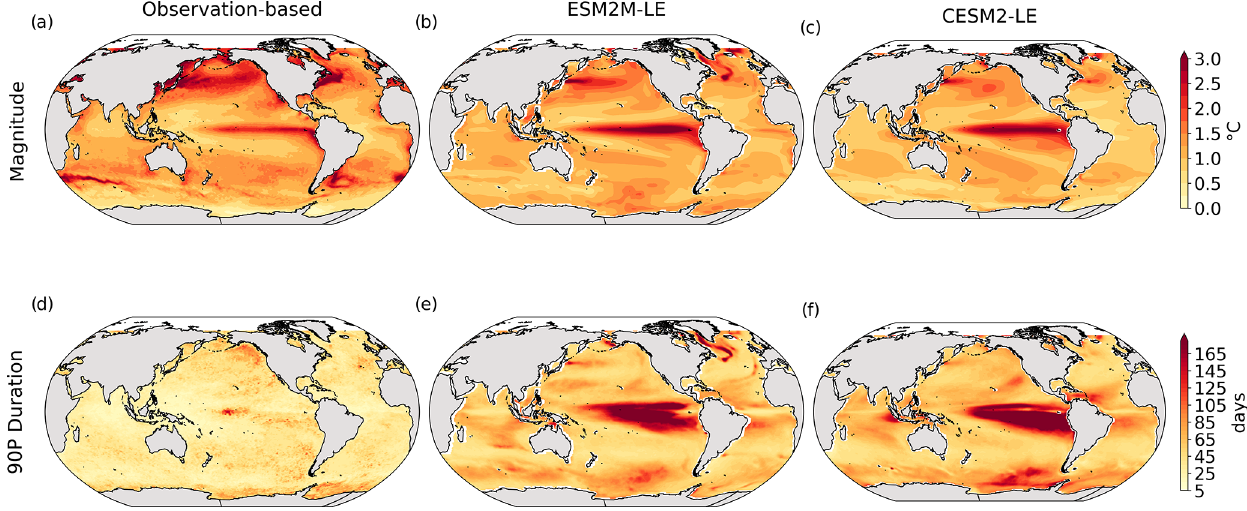
Figure B2. Simulated mean magnitude and duration of MHWs over 1998–2018. Mean SST anomaly relative to the seasonal cycle ( ◦ C) during MHWs in (a) the observation-based estimate, (b) ESM2M-LE, and (c) CESM2-LE. Simulated 90th percentile of the MHW durations (days) in (d) the observation-based estimate, (e) ESM2M-LE, and (f) CESM2-LE. The global mean magnitude equals 1.3, 1.2, and 1.2 ◦ C, while the global mean 90th percentile of the duration equals 36, 69, and 75d in the observations, ESM2M-LE, and CESM2-LE, respectively.